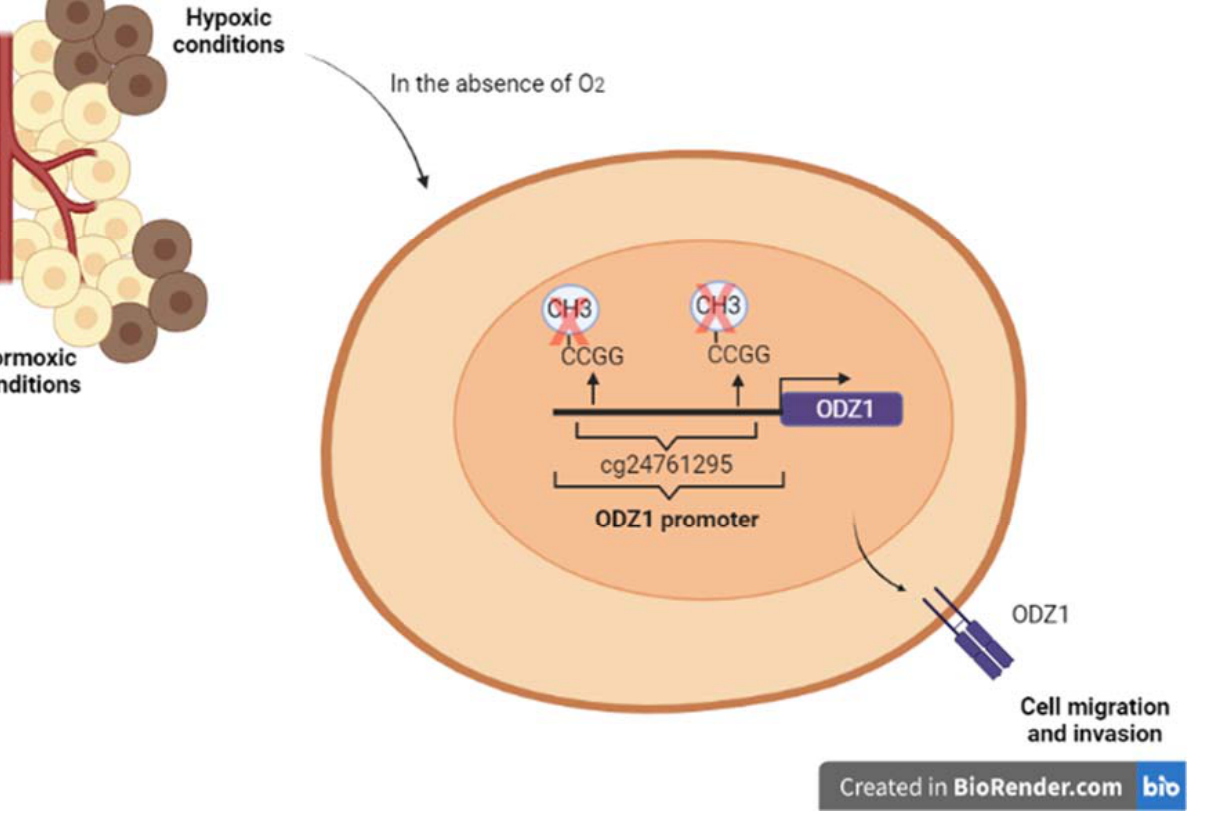
Figure 3. Hypoxia regulates the expression of ODZ1 by hypomethylation of a CpG site in the ODZ1 promoter. In samples of GBM patients, hypoxic and normoxic regions were identified by immunohistochemistry and the methylation status of CpG sites within the ODZ1 promoter was analyzed. Hypoxic GBM cultures showed a hypomethylation status of a CpG site (cg24761295). This hypomethylation facilitates ODZ1 expression, and in consequence, cell migration